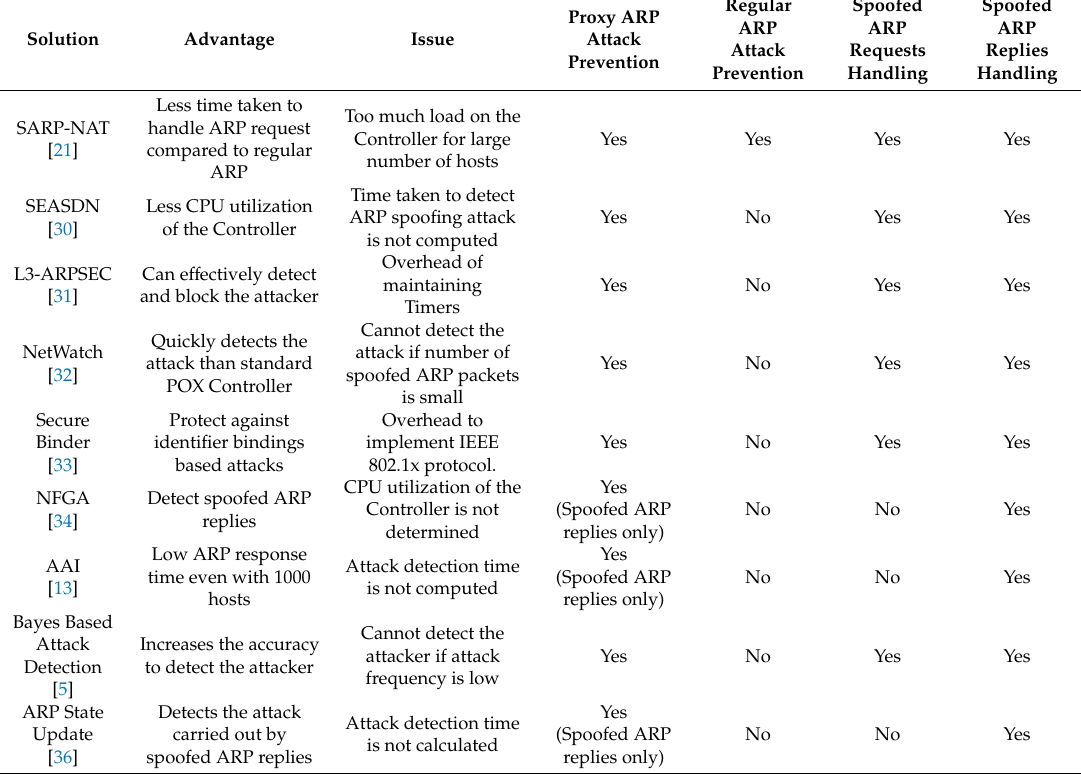
Table 3. Summary of Maintaining IP-MAC Address Bindings on the Controller Based